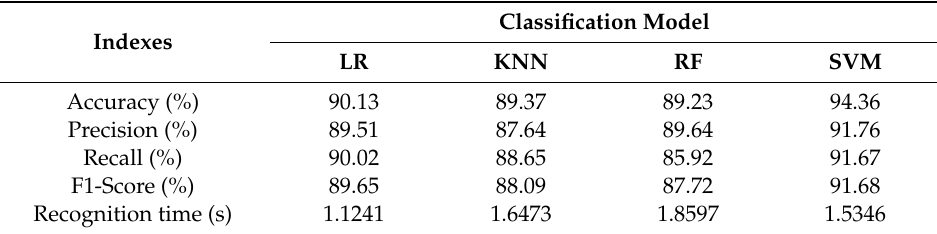
Table 4. Overall average recognition ability comparisons of di ff erent classification